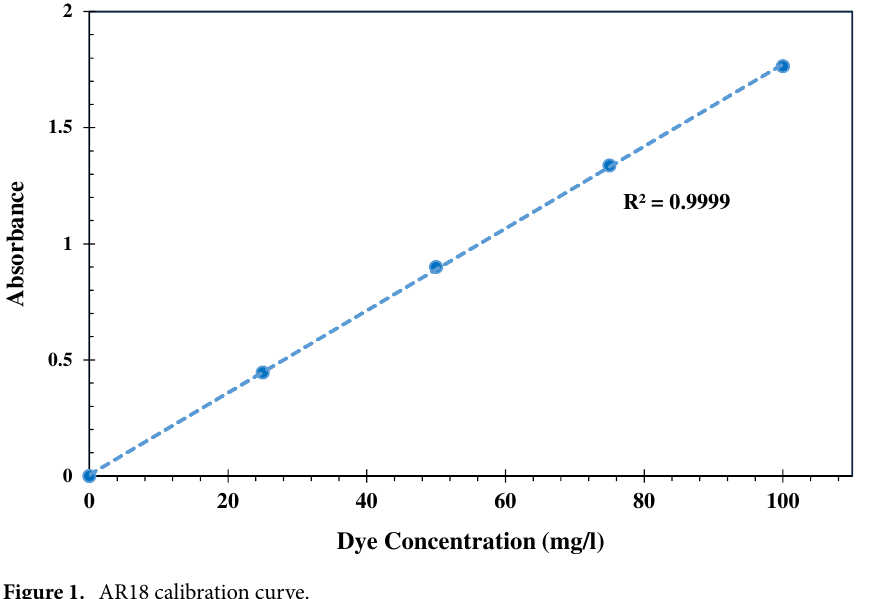
Figure 1. AR18 calibration